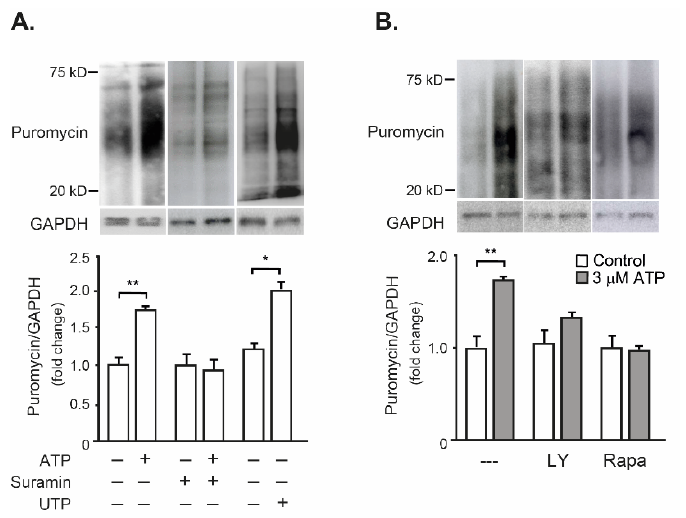
Figure 4. Exogenous ATP promoted protein synthesis in mouse FDB muscle, dependent on the P2YR-Akt-mTOR signaling pathway. Isolated FDB muscles were incubated without ( − ) or with (+) 3 µM ATP or UTP. A pulse of puromycin was performed during the incubation with the nucleotides. After that, 30 min chase with an unlabeled medium was carried out. Proteins from whole muscle extracts were resolved by SDS/PAGE, and neo-synthesized peptides were detected by immunoblot with an anti-puromycin antibody. For each figure, a representative immunoblot was shown at the top panel, and the quantitation of four independent experiments was graphed in the bottom panel (mean ± SEM). ( A ) ATP evoked protein synthesis in isolated FDB muscle, which is prevented by 30-min pre-incubation with 100 µM Suramin (P2Y/P2X receptor antagonist). UTP, a P2Y 2 -P2Y 4 receptor agonist, also increased protein synthesis in isolated FDB muscle. ( B ) The increase in protein synthesis evoked by extracellular ATP in FDB muscle was abolished by 30-min pre-incubation with 50 µM LY294002 (LY, PI3-kinase inhibitor) or 100 nM Rapamycin (Rapa, mTOR inhibitor). * p < 0.05; ** p < 0.01, Mann–Whitney test.